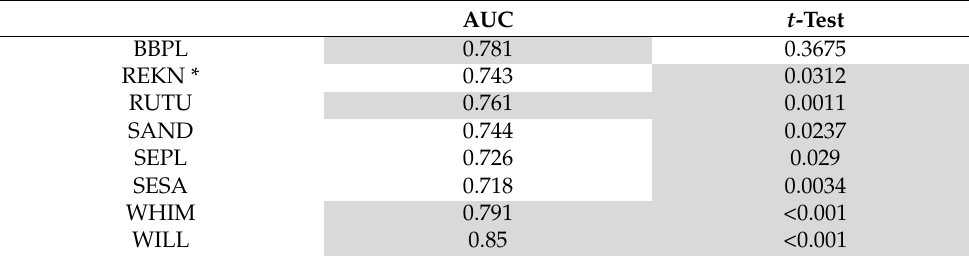
Table 2. AUC scores and t -test comparing presence and absence points of reserved validation data. Shaded boxes indicate models with AUC scores greater than the 0.75 threshold suggested for useful discrimination of presence. Shaded boxes in the t -test column indicate models that passed the validation test with a mean predicted probability of presence higher in presence points compared to absence points of the reserved validation data. AUC t -Test